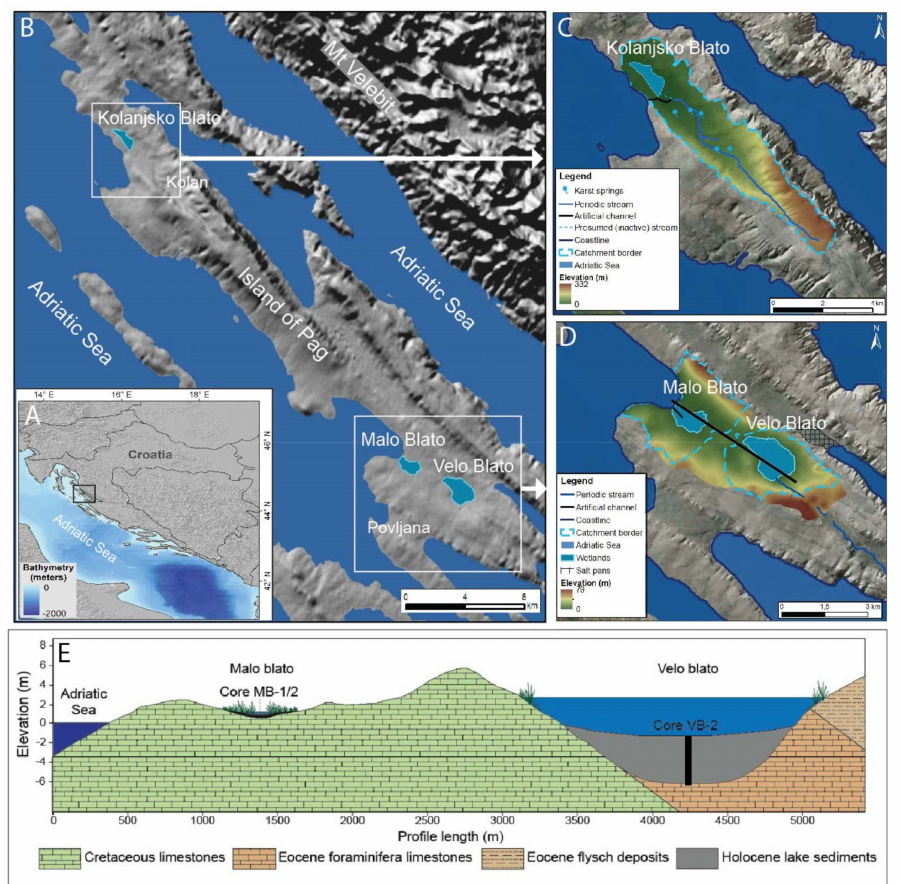
Figure 1. ( A ) The Island of Pag in Croatia, in the central part of the eastern Adriatic coast (black rectangle) ( B ) The study locations of Kolanjsko, Malo and Velo Blato on the Island of Pag; shallow coastal wetland Kolanjsko Blato ( C ) and lake Velo Blato and wetland Malo Blato ( D ) detailed maps with catchments area. The black line in figure D presents a profile through Velo and Malo Blato ( E ) to emphasize geomorphological and geological settings. Note that boundaries between geological units are